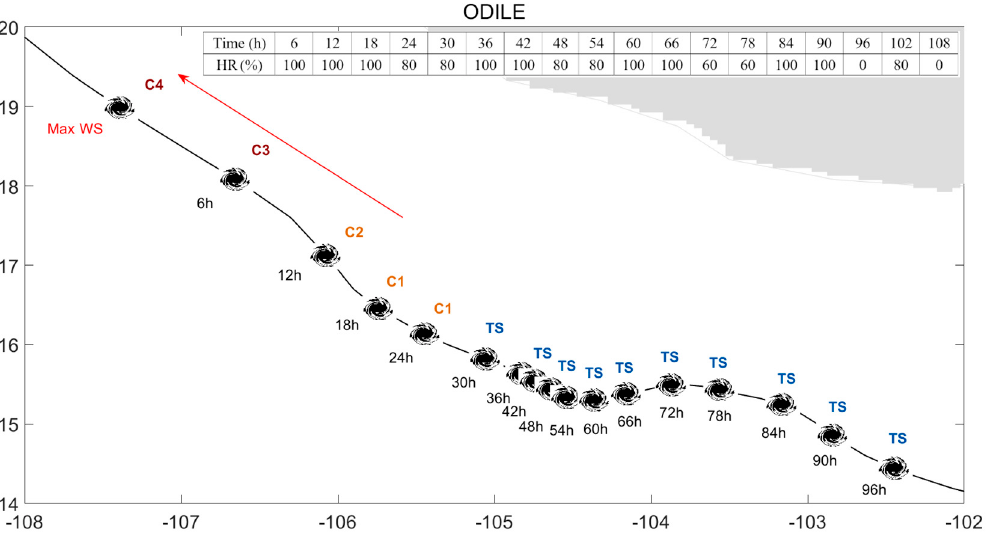
Figure 9. As in Figure 4, but for hurricane Odile (NE Pacific Ocean, 10–18 September 2014). Here, the TS was formed on 10 September 2014, at 06:00 UTC and it reached the Max WS on 14 September 2018, at 06:00 UTC.